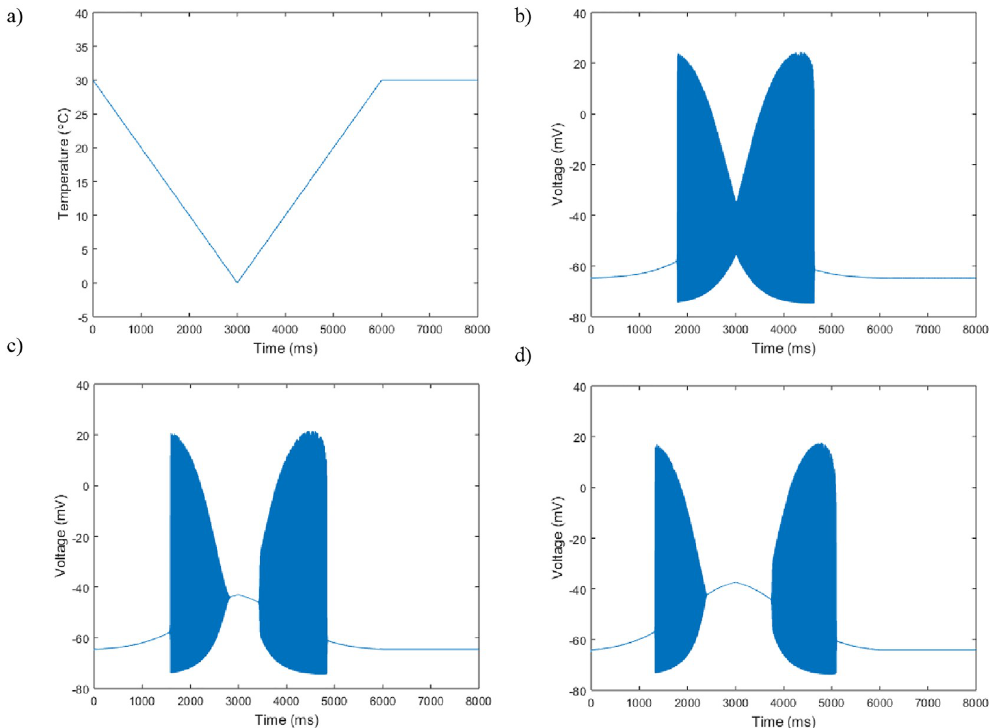
Fig 6. Membrane potential plotted against time in response to a simulated temperature ramp. a) The simulated change in temperature over time. b) The neuron’s periodic spiking behavior response to the temperature change plotted against time with g = 3. c) Here g = 5. d) Here g = 10. All other parameter values are set to Hodgkin-Huxley values. m 8 m 8 m 8